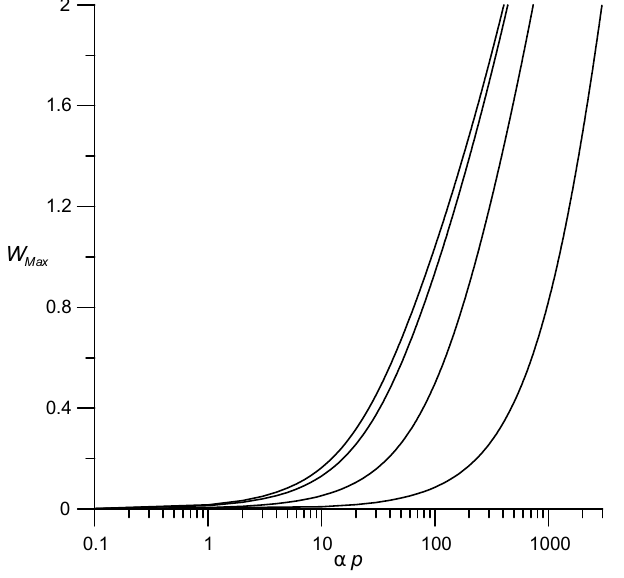
Fig. 6. Variation of the maximum nondimensional deflection W Max with the applied nondimensional load αp for clamped-free plates of inner radii b = 0 . 1 , 0 . 3 , 0 . 5 , and 0 . 7 .